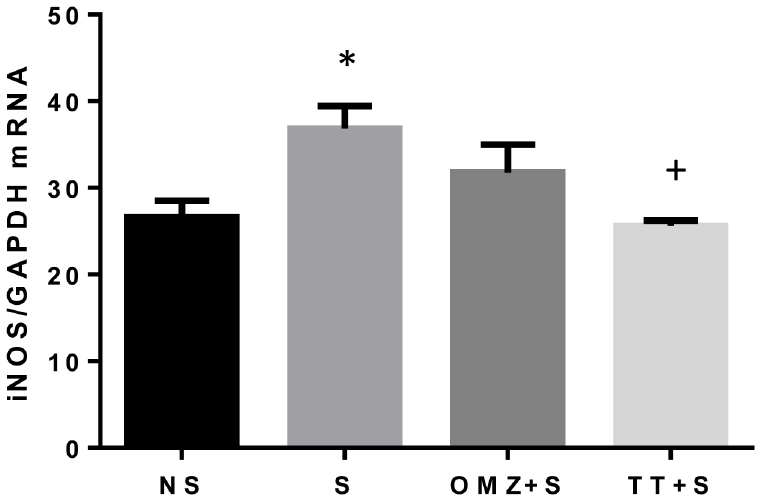
Fig 5. Effects of pre-treatment with tocotrienol (60 mg/kg BW) (TT) or omeprazole (20 mg/kg BW) (OMZ) on gastric inducible nitric oxide synthase (iNOS) mRNA expression in rats exposed to water immersion restraint stress (n = 7). * vs non-stressed control (NS) (P < 0.05). + vs stressed control (S) (P < 0.05).